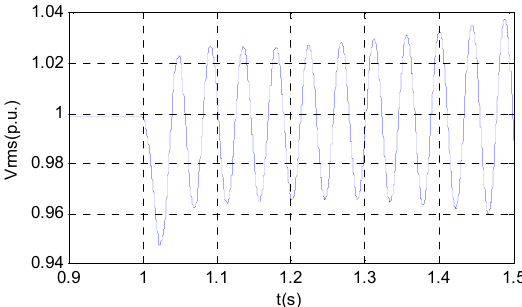
Figure 3. Electromagnetic oscillation induced by static VAR compensators (SVCs).